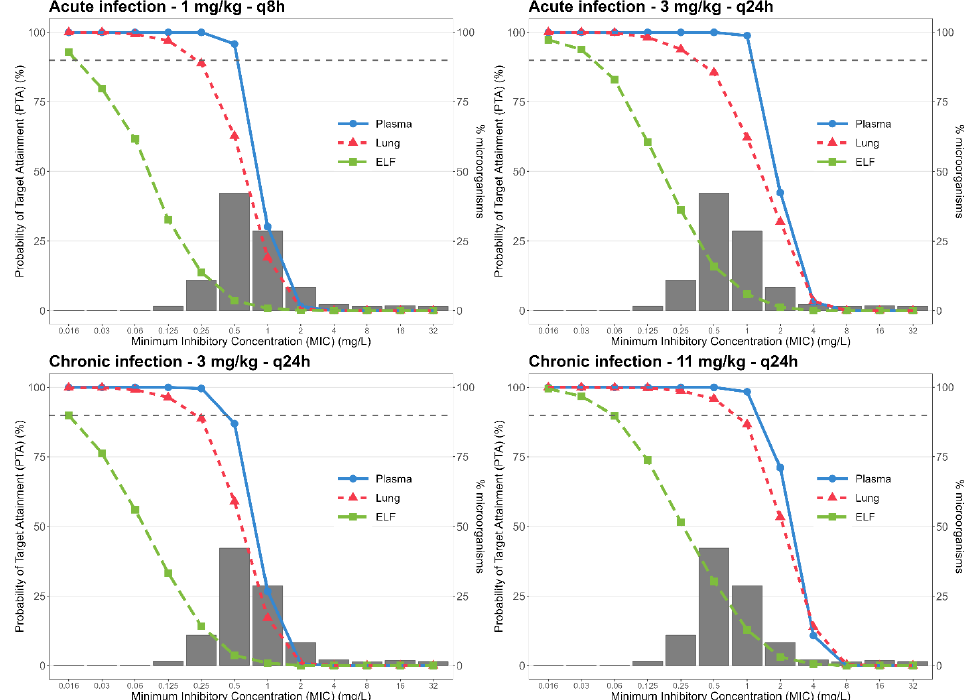
Figure 3. Probability of target attainment for a PK/PD index of f C max /MIC > 10 for P. aeruginosa for different TOB dosing regimens considering free plasma, free lung, and free ELF concentrations.